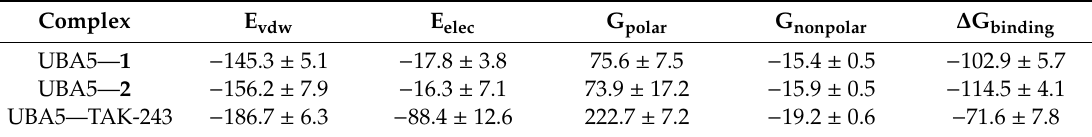
Table 2. Binding energies (kJ / mol) for alkaloids 1 – 2 and TAK-243 in complex with ubiquitin-like modifier-activating enzyme 5 (UBA5) using molecular mechanic / Poisson-Boltzmann surface area (MM / PBSA) method among 100–150 ns of molecular dynamics